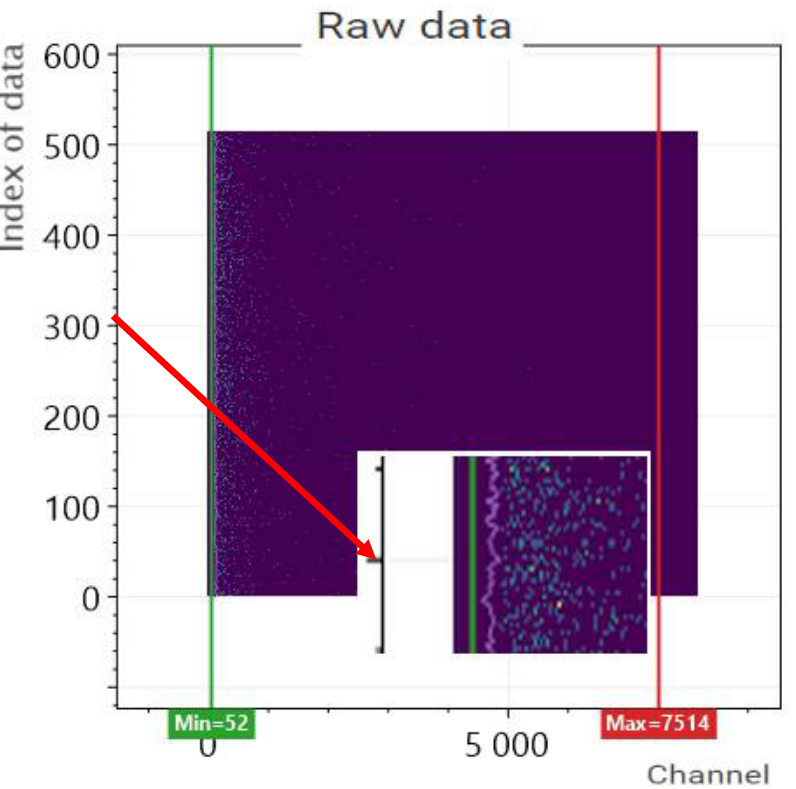
Figure 7. The monitor screen of the measured data obtained by the processing software.